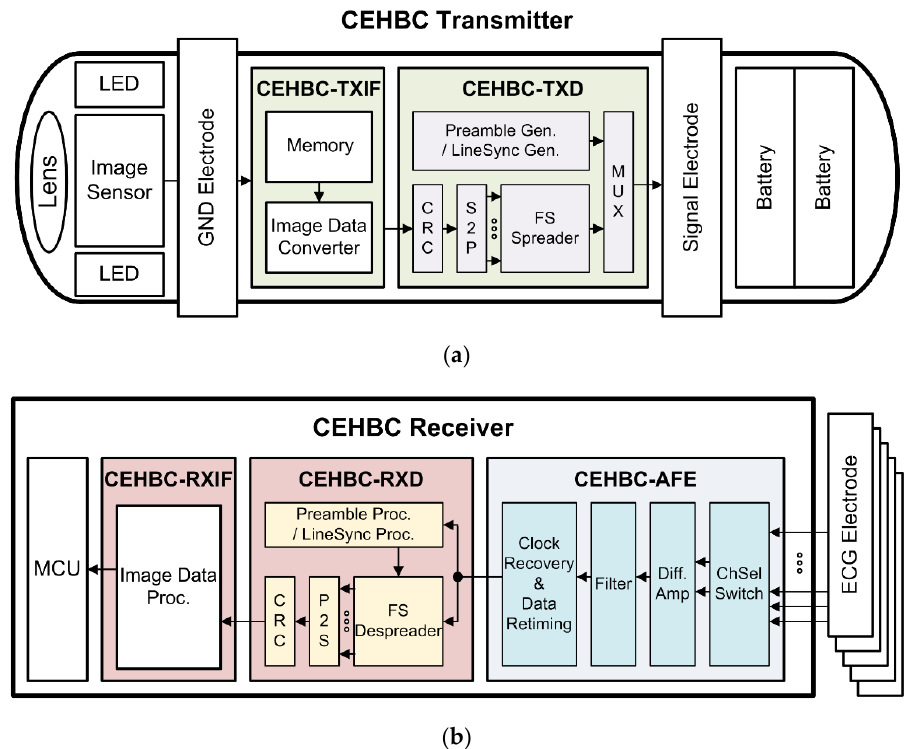
Figure 2. Block-diagram of the proposed capsule endoscopy with a human body communication (CEHBC) system: ( a ) CEHBC transmitter; ( b ) CEHBC